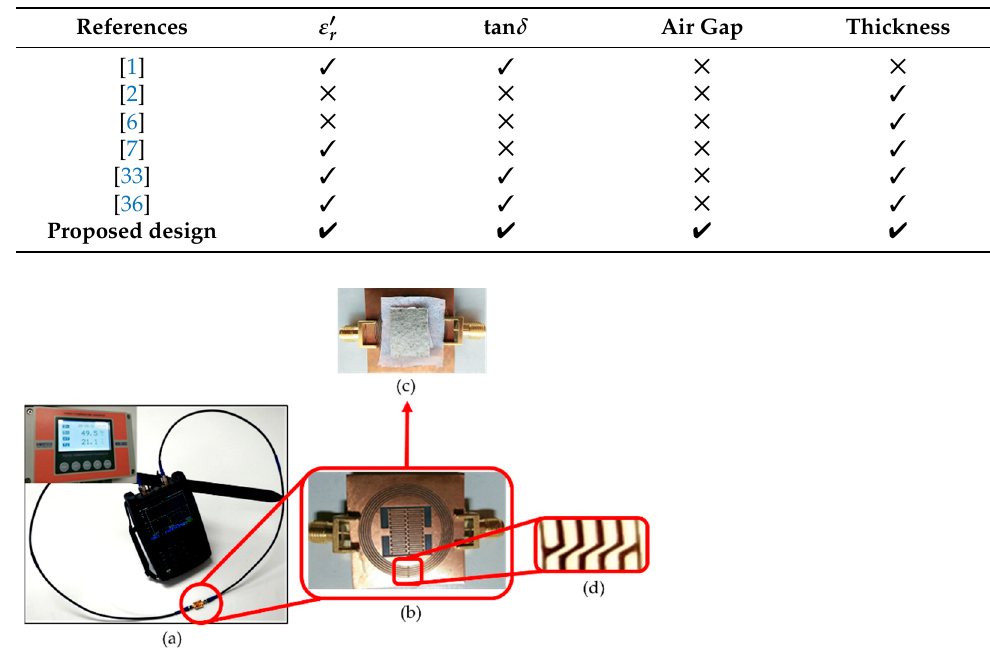
Table 4. Comparison of the designed sensor based on different performance characteristics.